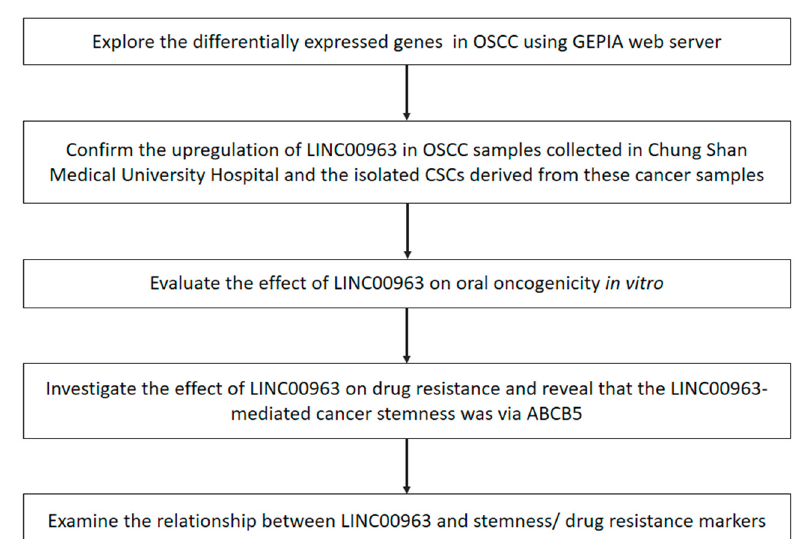
Figure 1. The flowchart of the experimental design. Figure 1 . The flowchart of the experimental design . Figure 1 . The flowchart of the experimental design .